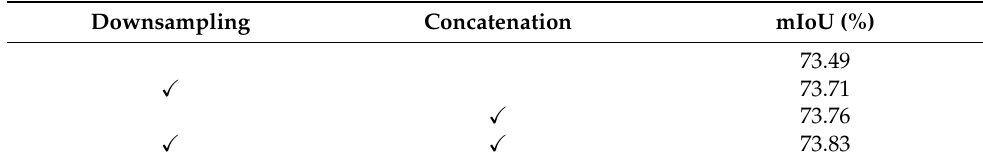
Table 4. Results of the LAB encoder with different settings. n = 2, m = 2, l = 4.